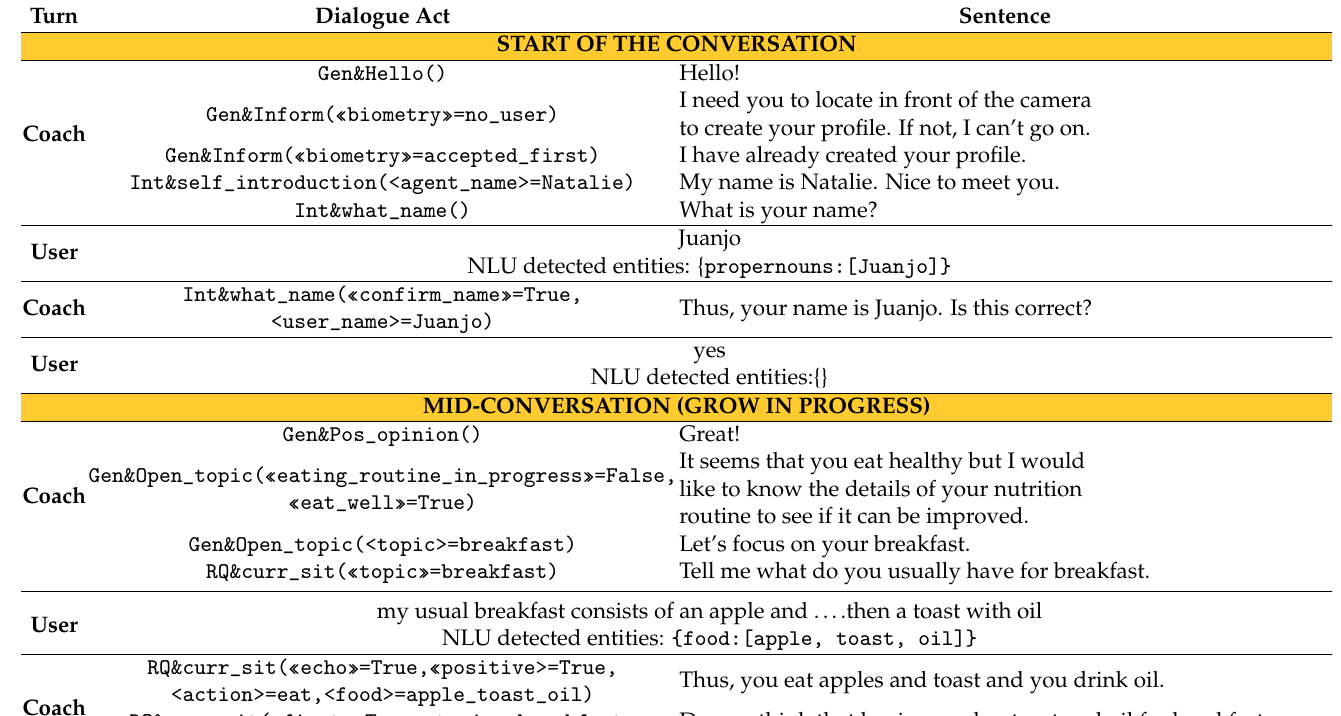
Table 1. Extracts of a conversation between an end-user and the VC, which has been translated from Spanish into English. Column 2 depicts the DAs of each Coach turn, which defines the output of the DM and consistently the input of the NLG. Each DA generates a sentence shown in Column 3 that is part of the Coach turn under consideration. User turns only show the transcription of what the user said as well as the entities detected by the NLU, if